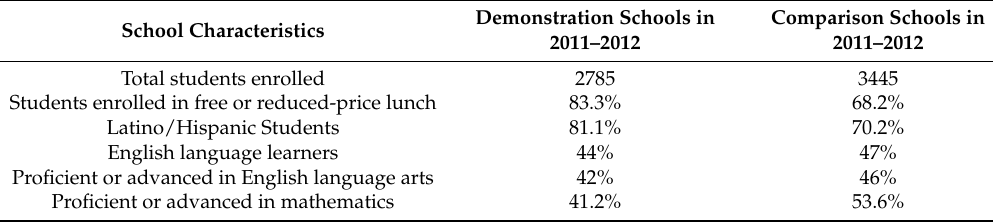
Table 1. Student demographics in demonstration and comparison schools in